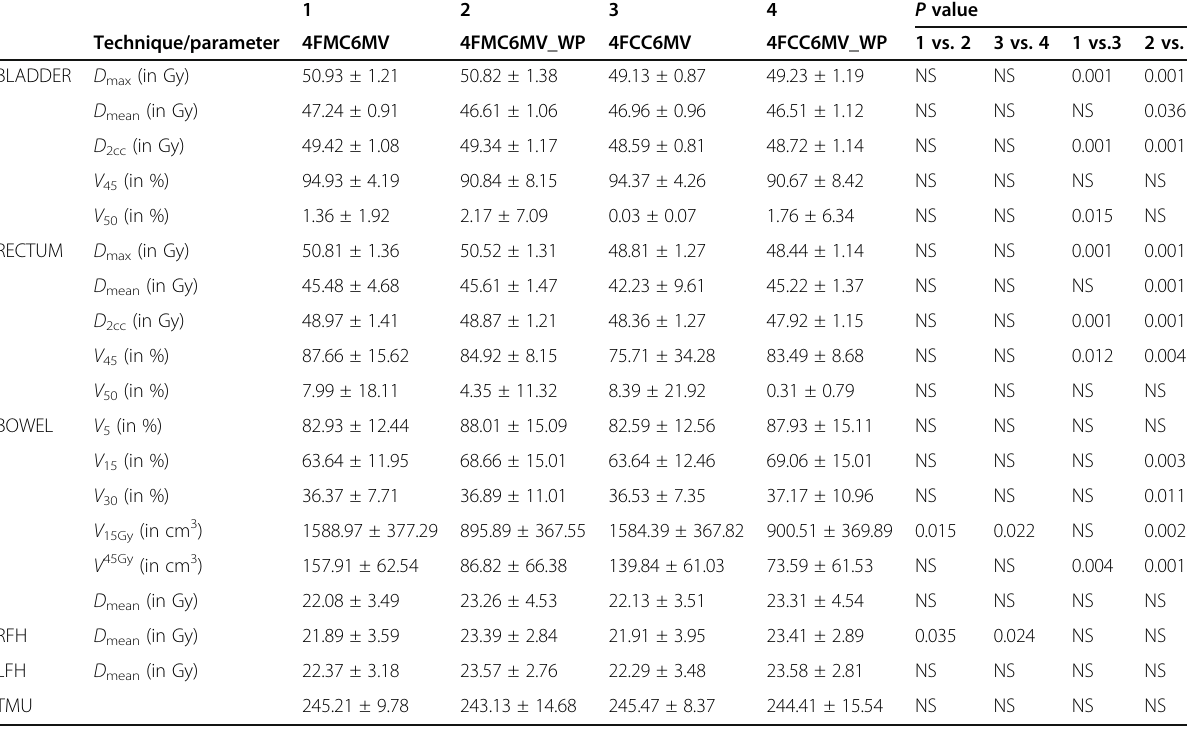
Table 2 Evaluation parameters for OARs and their P